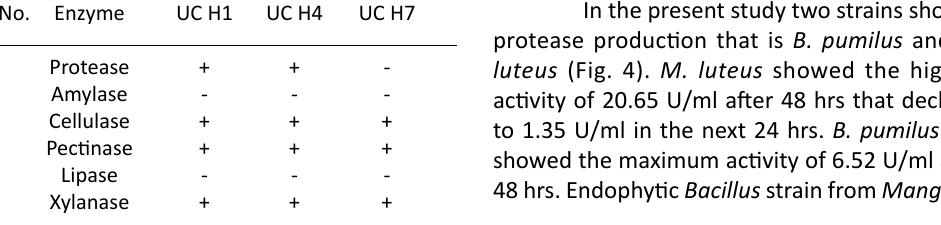
Table 4. Primary screening of three endophytic bacterial isolates Sl. No. Enzyme